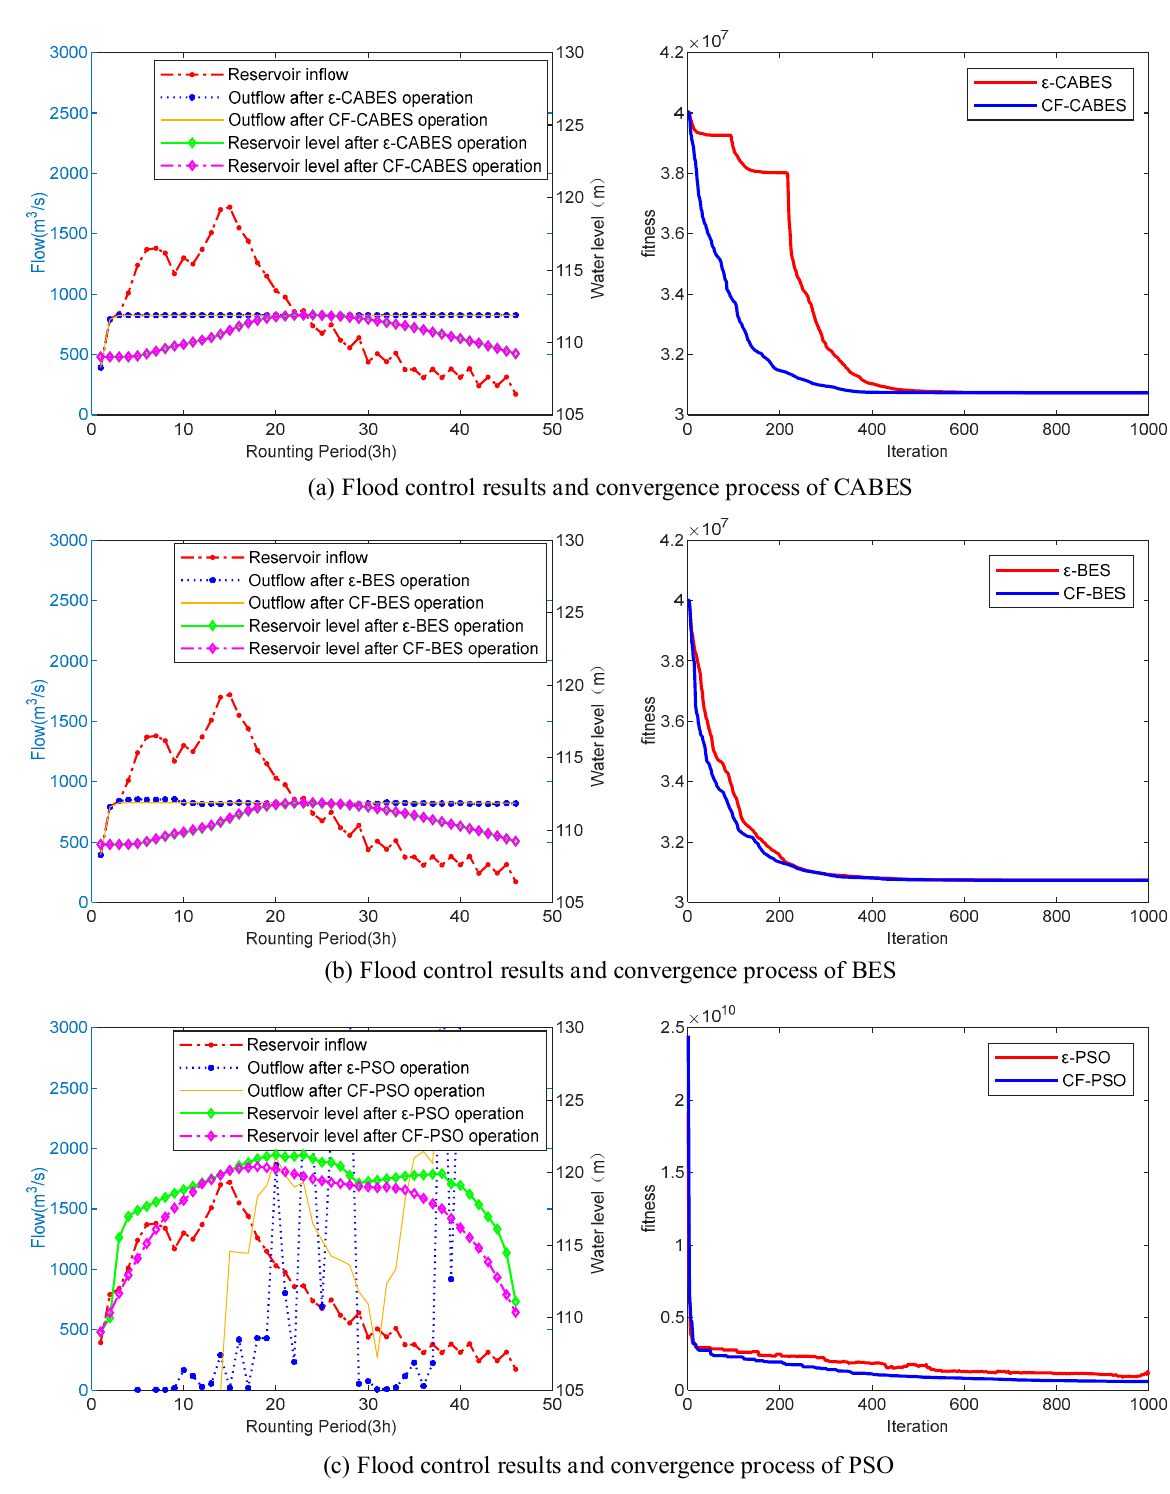
Figure 4. Comparison of operation processes of Dahuofang Reservoir with different algorithms.